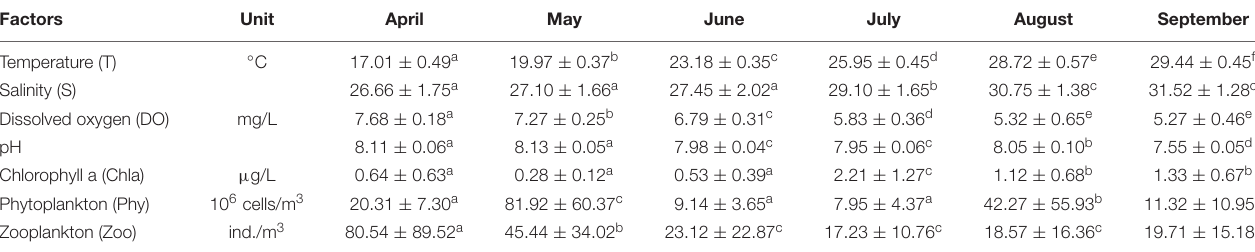
TABLE 1 | Temporal variation in abiotic and biotic factors (mean ± SD, n = 25 stations) from April to September 2019 in Sansha Bay of Fujian Province, China. Factors Unit